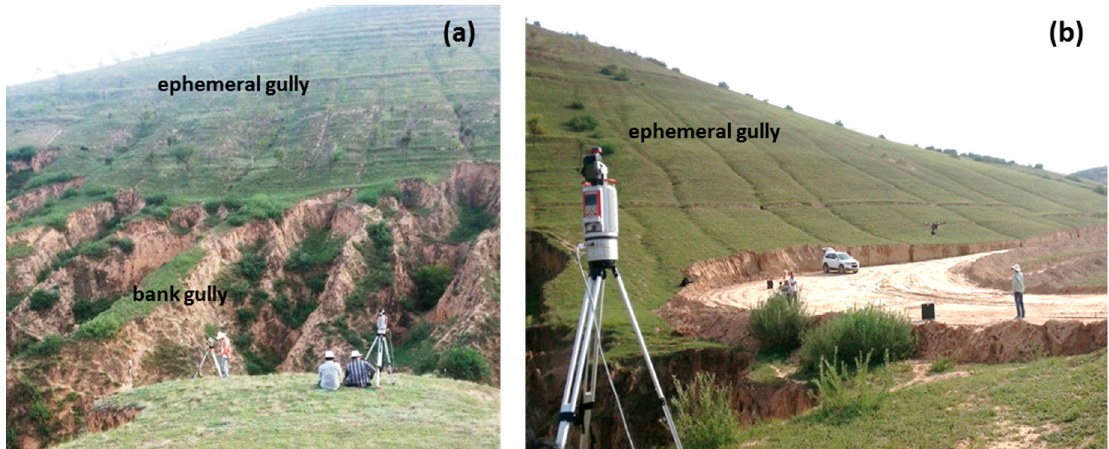
Figure 1. Pictures of ephemeral gullies in Jingbian (test area, T1), Loess Plateau of China: ( a ) ephemeral gullies in south side slope; ( b ) ephemeral gullies in the west side slope.